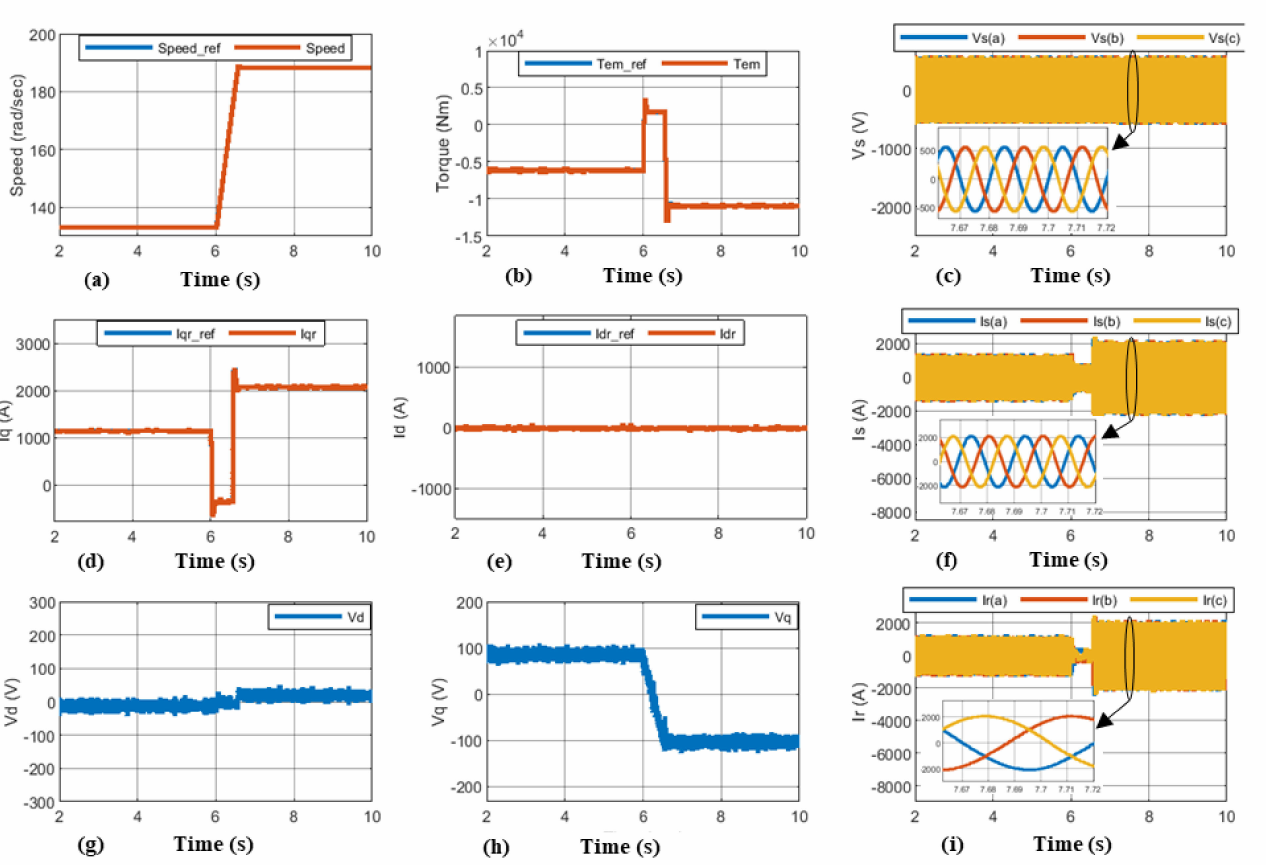
Figure 5. SS response of the simulated system with a rotor speed of 188.5 rad/sec; ( a ) Speed, ( b ) Torque, ( c ) Stator Voltage, ( d ) q-axis Current, ( e ) d-axis Current, ( f ) Stator Current, ( g ) d-axis voltage, ( h ) q-axis Voltage, ( i ) Rotor